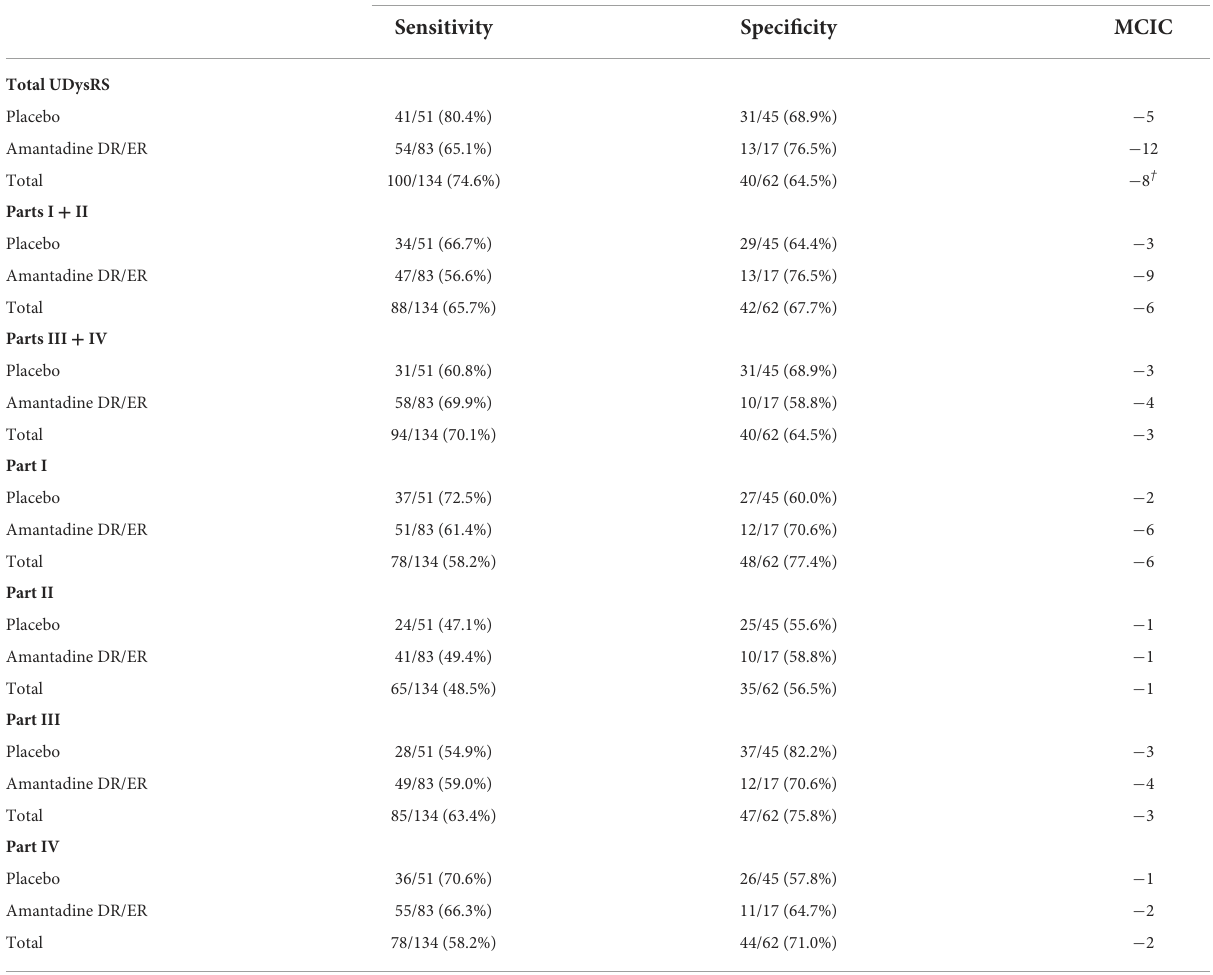
TABLE 5 Determination of minimal clinically important change * in the Unified Dyskinesia Rating Scale scores anchored to minimal improvement in the Movement Disorder Society-Unified Parkinson’s Disease Rating Scale Part IV, item 4.2, by treatment group and for overall